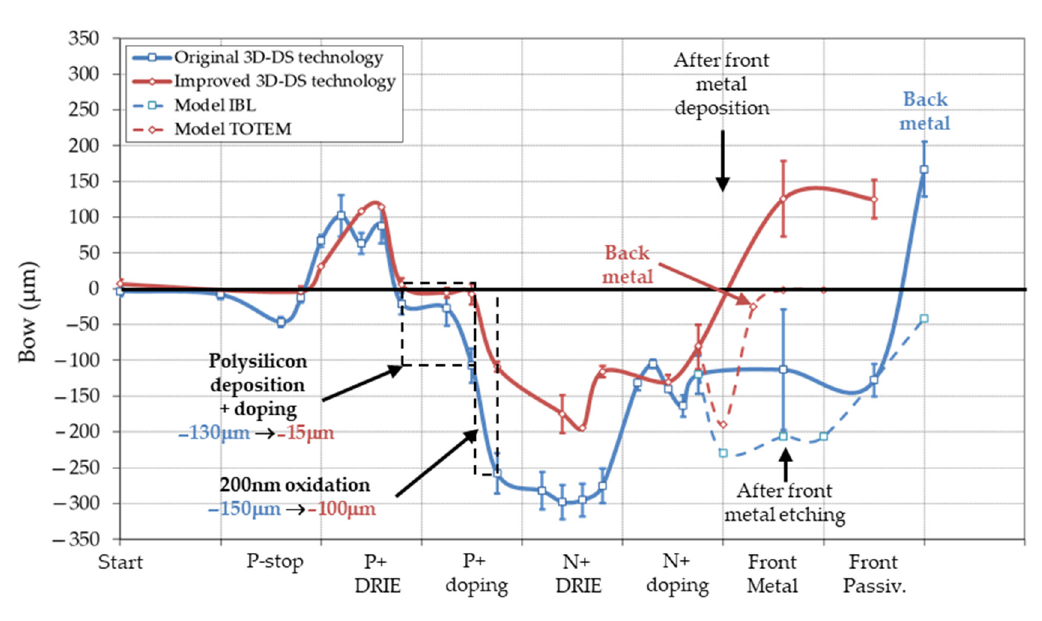
Figure 13. Bow variation during two 3D-DS processes (wafer thickness: 230 µ m) and planar models for the metallization. Main causes of curvature are indicated on the graph.